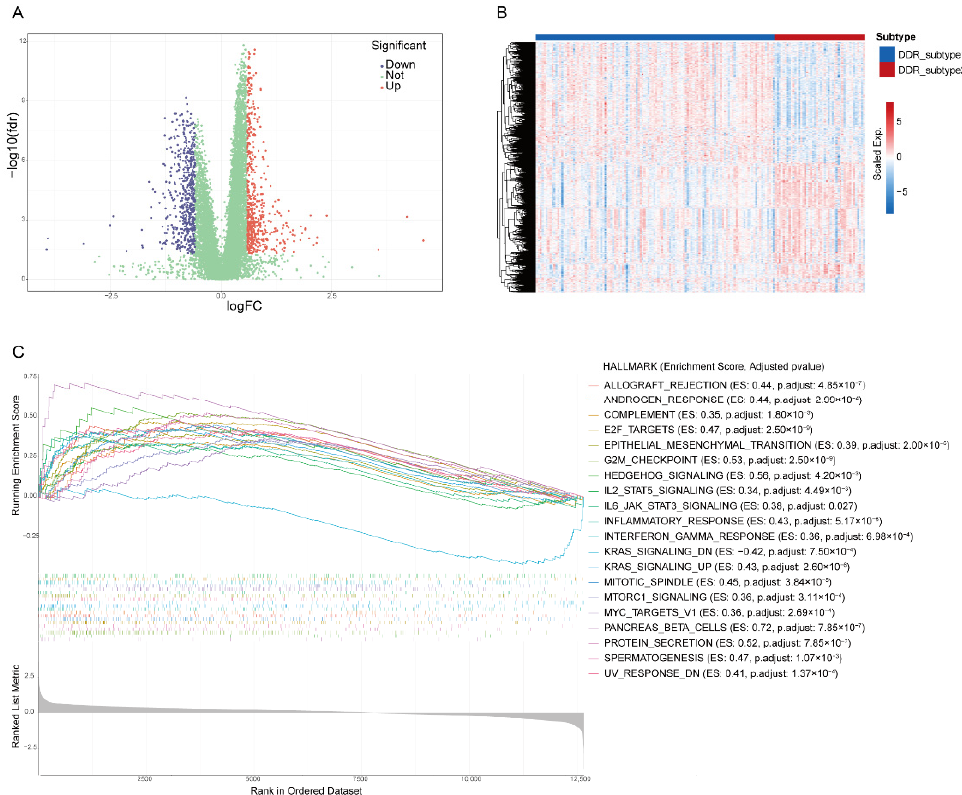
Figure 4. Identification of differential expression genes (DEGs) and related biological processes of DDR subtypes. Volcano plot ( A ) and heatmap ( B ) of DEGs in PAAD based on data from TCGA. ( C ) The top 20 hallmark gene sets of Gene Set Enrichment Analysis of DEGs.